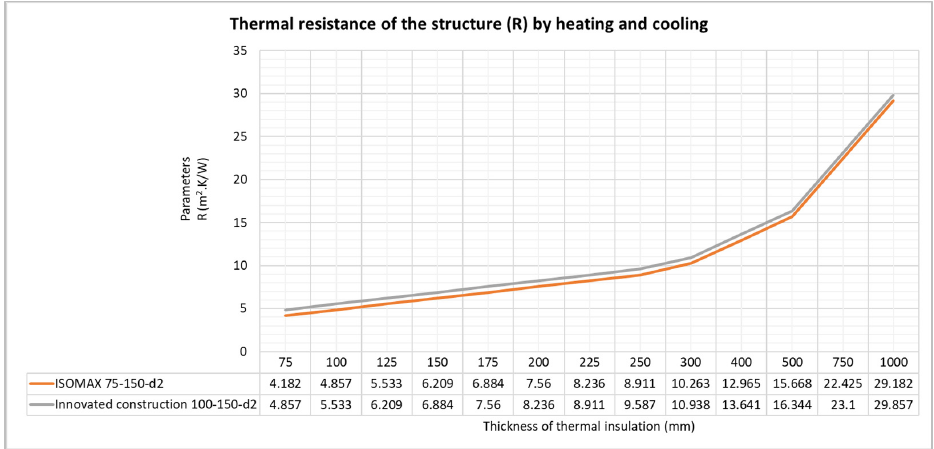
Figure 20. Dependence of the thermal resistance R of the ISOMAX panel and the innovative panel on the thickness of the exterior thermal insulation.